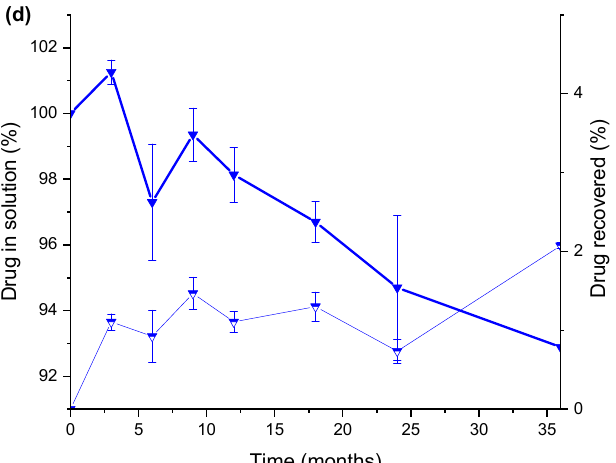
Figure 6. Correlation between drug recovery in solution (full colour symbol) and drug retained in the elastomeric gasket (half full colour symbol) at 25 °C. Key: ( a ) Diazepam in sealing type PH 701/50 C BLACK JEA, ( b ) diazepam in sealing type 4023/50 GRAY JEN, ( c ) midazolam in sealing type PH 701/50 C BLACK JEA, and ( d ) midazolam in sealing type 4023/50 GRAY JEN.